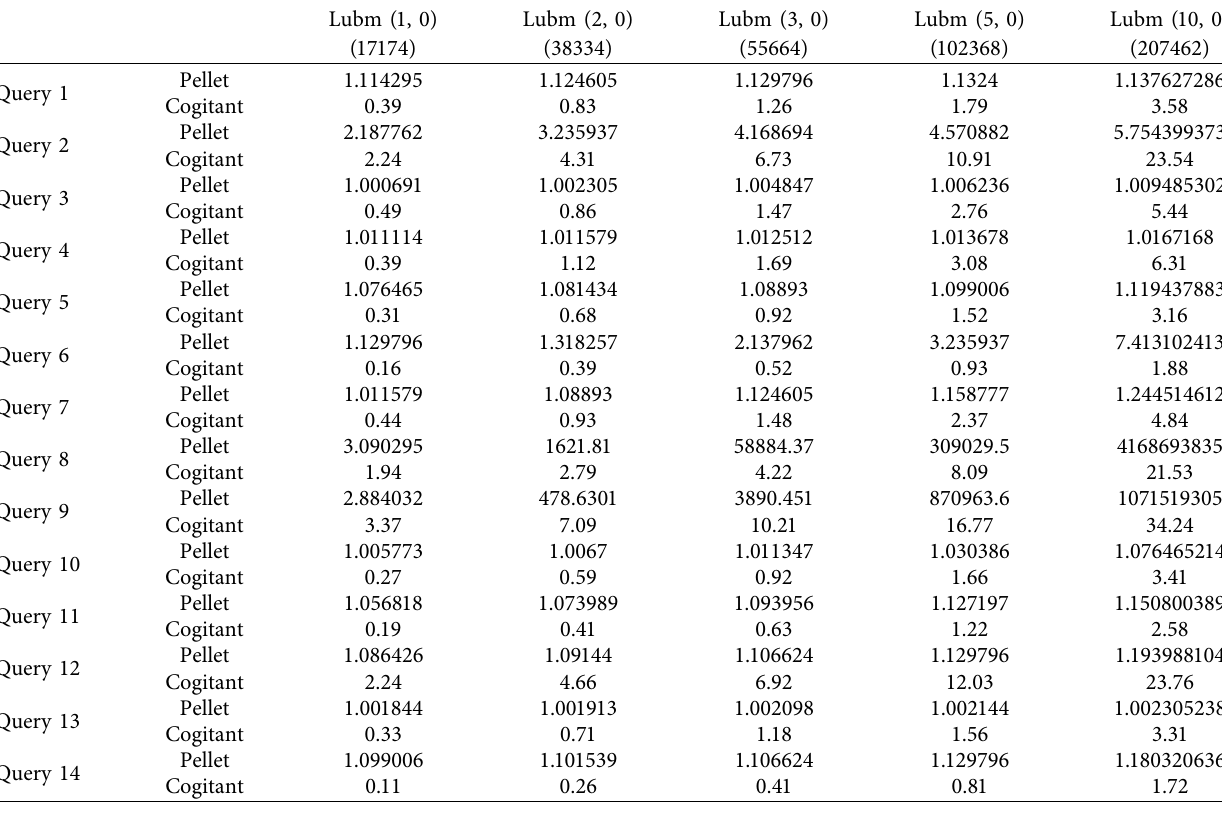
Table 5: Time cost of executing 14 queries (s).